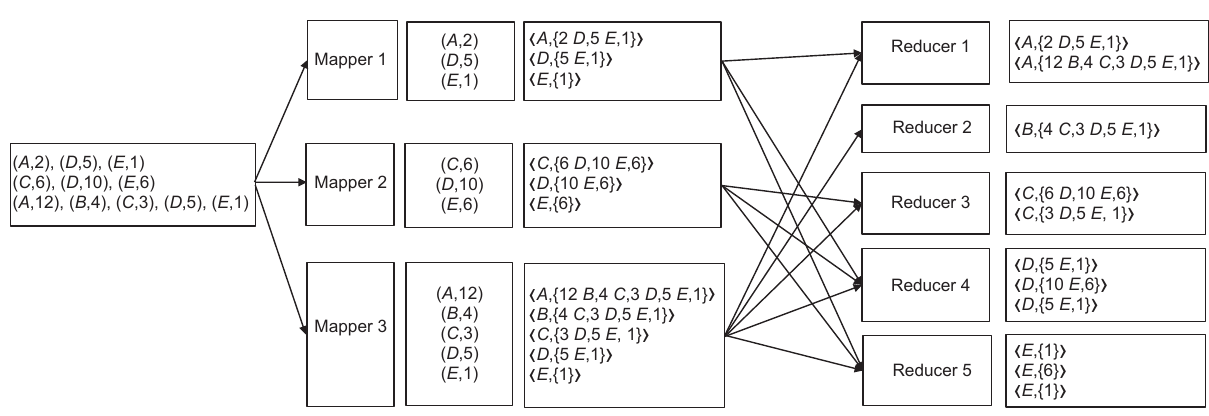
Fig. 2 Data decomposition process.